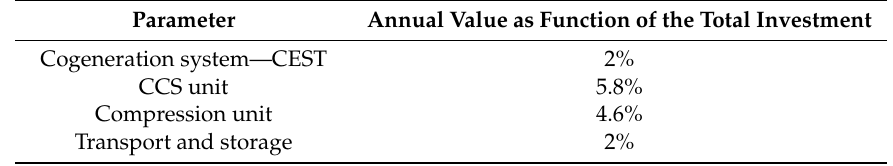
Table 2. Assumptions for operation and maintenance